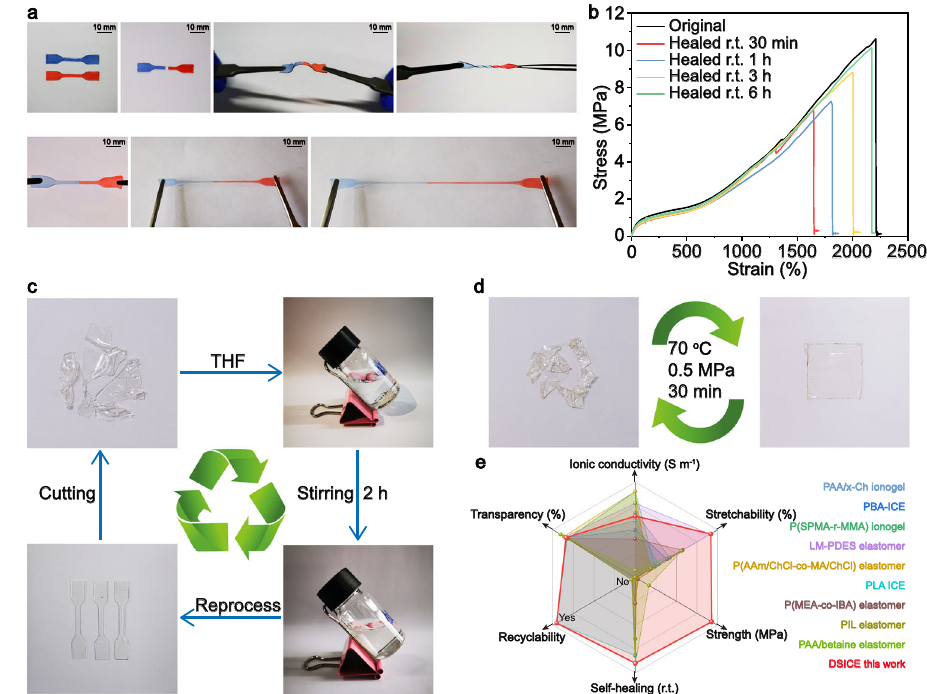
Fig.5|Autonomousself-healingcapabilityandmultiplerecyclabilityofDSICE. a Tensile curves of the original and self-healed DSICE-30 sample after different healing time from 30min to 6h at room temperature. b Photograph of DSICE-30 before and after self-healing. The colored dumbbell DSICE-30 was cut into two pieces and then put any two pieces into contact. After self-healed for 10min, the jointedsamplecanbebent,twistedandevenstretchedto100%,400%,800%ofthe